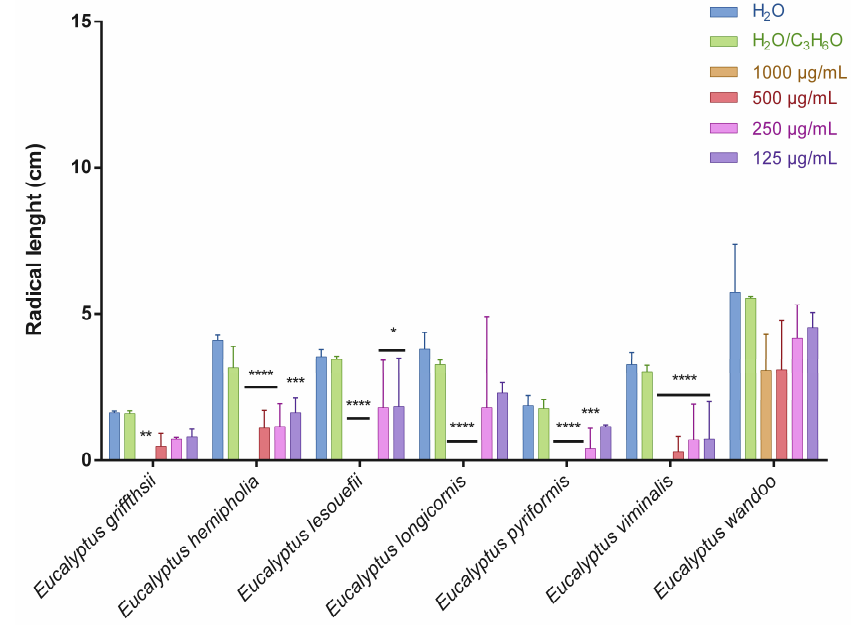
Figure 4. Radical length of Raphanus sativus seeds after treatment with different concentrations (125–1000 µg/mL) of Eucalyptus essential oils measured 120 h after sowing. Results are the mean ± standard deviation ( n = 3) of three independent experiments. * p < 0.05; ** p < 0.01, *** p < 0.001, **** p < 0.0001 compared to control (ANOVA followed by Dunnett’s multiple comparison test).